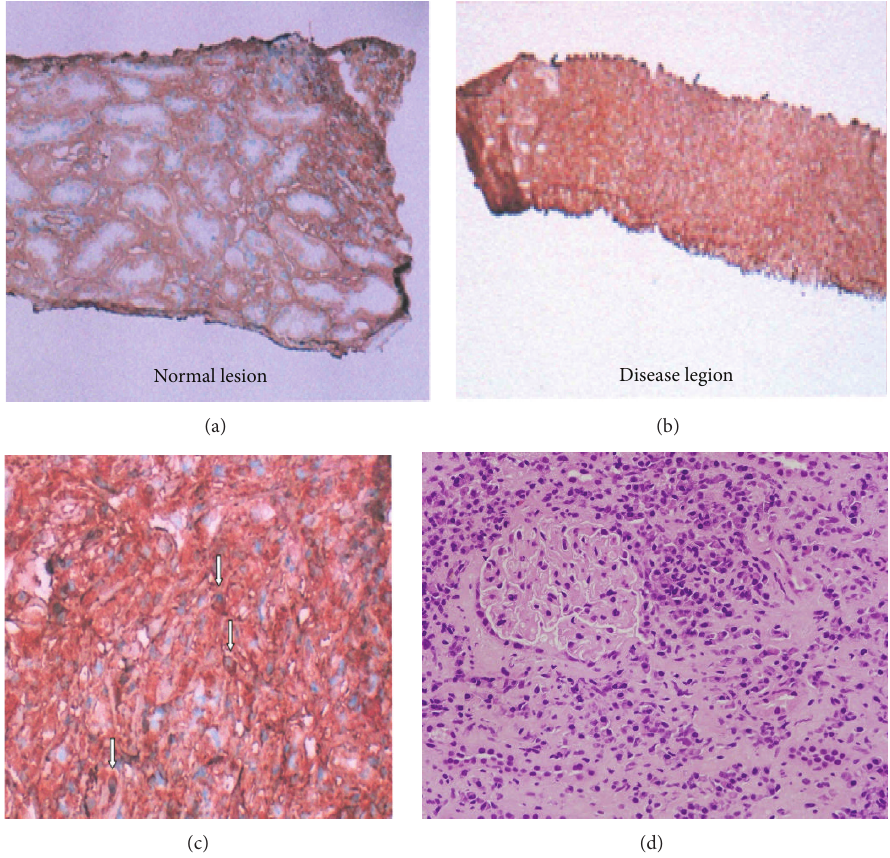
Figure 3: Histopathological findings of the specimen obtained by needle renal biopsy. IgG4 staining (a, b, c) revealed infiltration of numerous IgG4-positive cells and absence of normal structure in some parts of the interstitium and almost-normal structures with only slightly edematous interstitium in other parts. The IgG4/IgG ratio of infiltrating plasma cells was over 90%. Formation of crescents and mesangium cell proliferation were not evident in glomeruli in HE staining (d).